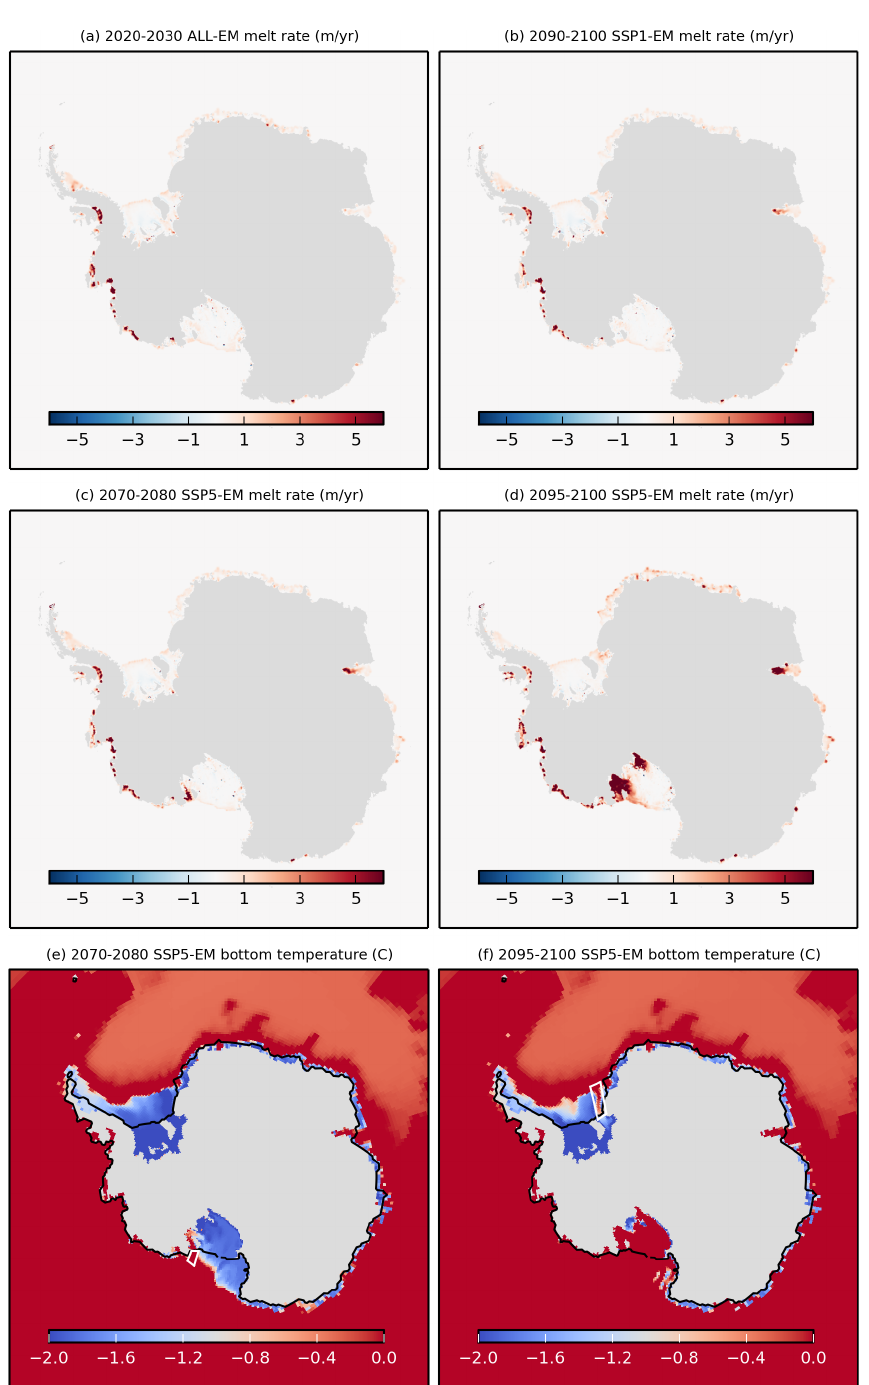
Figure 6. Antarctic ice shelf melt rates (myr − 1 ): (a) average for 2020–2030 for ALL-EM, (b) average for 2090–2099 for SSP1-EM, (c) average for 2070–2080 for SSP5-EM and (d) average for 2095–2100 for SSP5-EM. Bottom temperature ( ◦ C): (e) average for 2070– 2080 for SSP5-EM and (f) average for 2095–2100 for SSP5-EM. The white boxes in (e) and (f) represent the Little America Basin and Filchner Trough, respectively, whereas the black line indicates the ice sheet extent (coastlines).